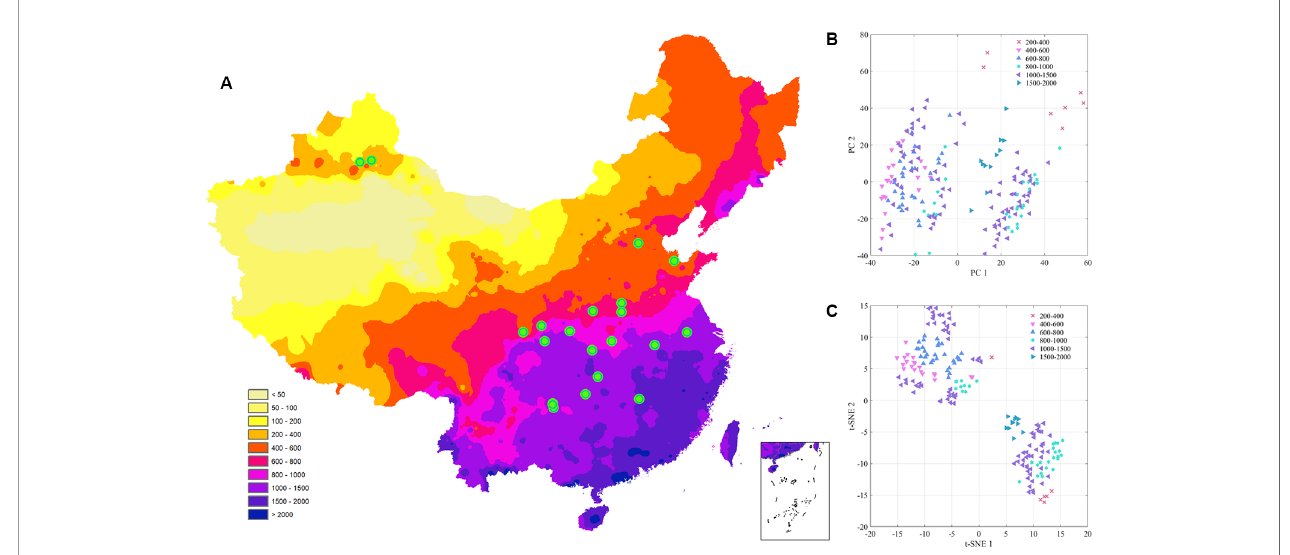
FIGURE 6 | The exploratory analysis results of Eucommia ulmoides leaves (EUL) samples in annual average precipitation (A) : The distribution of each collection site; (B) : PCA; (C) : t-SNE.